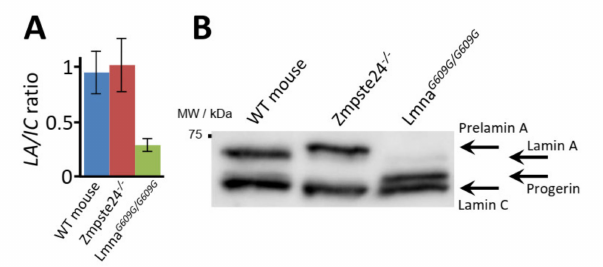
Figure 4. Detection of mature lamin A and progerin in skin fibroblasts from wild-type, Zmpste24 − / − , and Lmna 609G/G609G mice. ( A ) LA/IC ratio obtained in shotgun mass spectrometry (MS) experiments. ( B ) Western blot analysis.